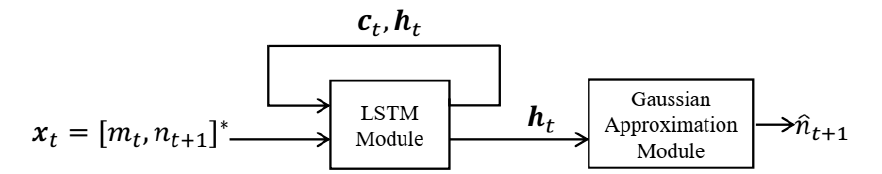
Figure 1. The structure of the N-LSTM.